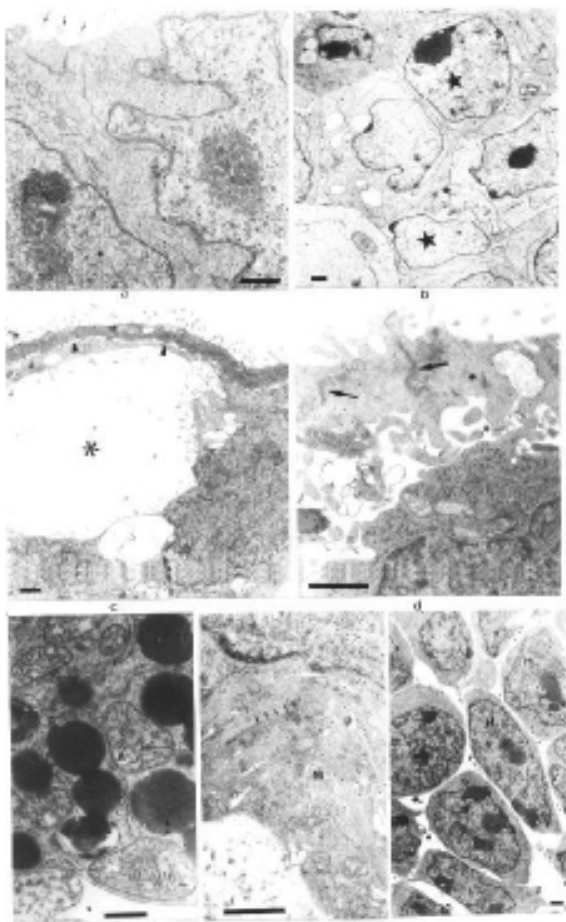
Figure 5 - Electron micrographs showing parts of HM -1 cell derived embryoidbodies(EBs).A3-dayembryoidbody(EB)showingtheappear- ance of the outer layer of endodermal cells with a few microvilli ( ↑ ) and cytoplasm with only a few organelles (5a, 12000x). The same EB showing the central part formed by undifferentiated cells ( (cid:2) ) (5b, 4300x). Figures 5cto5gallshow9-dayEBs:Reichert’smembrane( (cid:1) )andthecysticcav- ity (*) (5c, 6300x); endodermal cells with a large number of microvilli ( ↑ ) and junction structures ( (cid:1) ) (5d, 17600X); different types of cells can be seen in the inner part of EBs, e.g. adipose-like cells (A) (5e 12000x), mus - cle-like cells (M) and myofibers ( ↑ ) (5f, 1800x), haematopoietic stem-like cells (H) (5g, 3300x). Bar = 1 µ m.